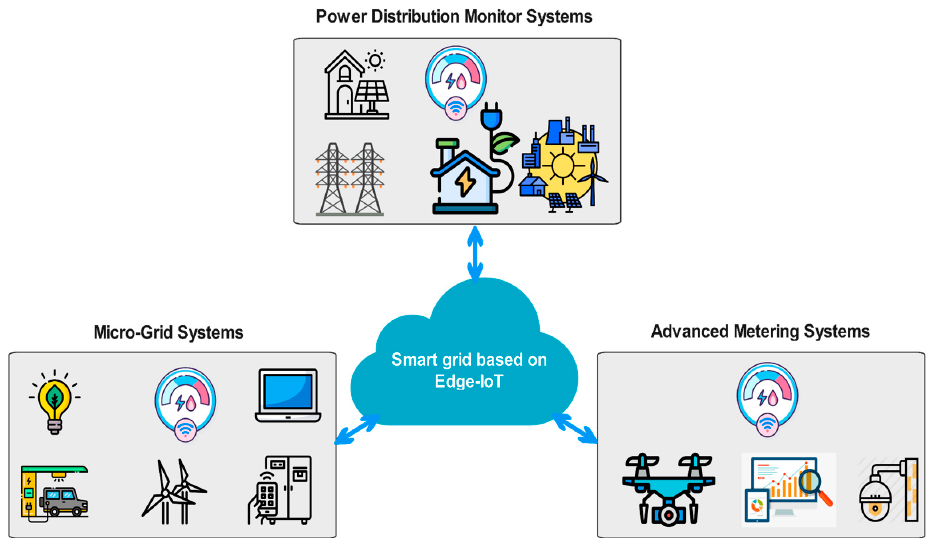
Figure 2. The three key services of IoT-based smart grids.